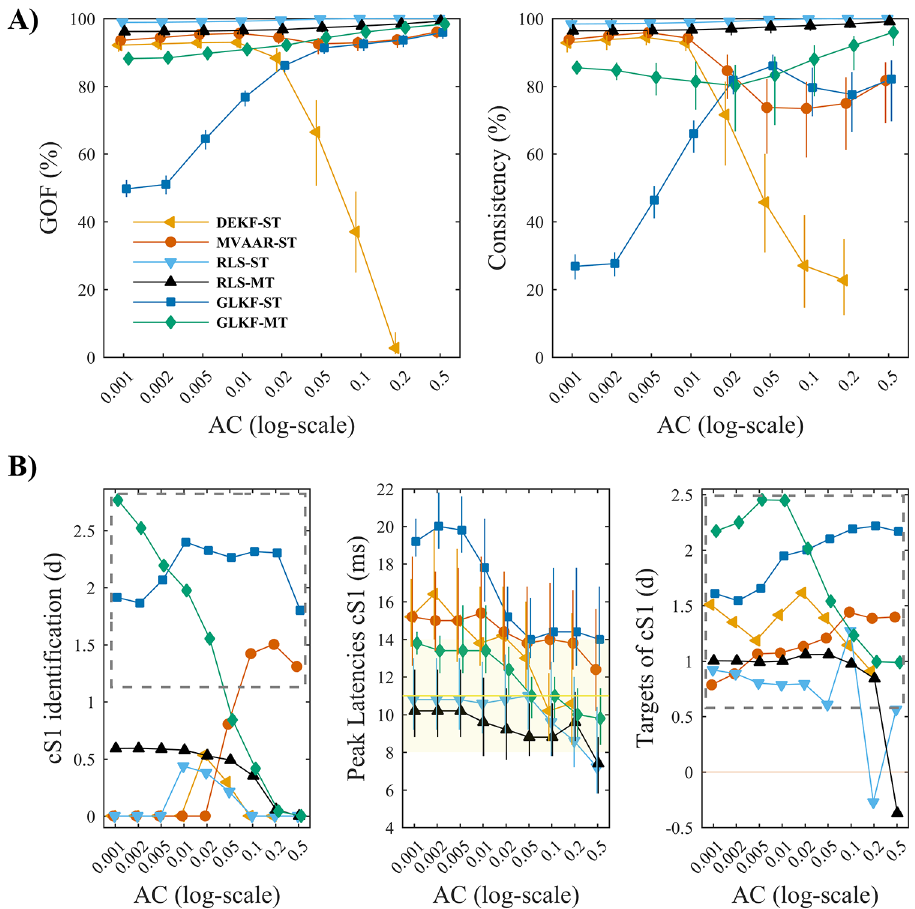
Fig 7. Effects of varying adaptation coefficients in benchmark EEG data. A) Shows the measures of model quality, goodness-of-fit (left) and percent consistency (right). Error bars denote bootstrapped 95% CI around the mean across animals. B) Shows the results of the performance assessment using the three performance criteria. Criterion I (left): gray dashed rectangle indicates conditions in which cS1 was significantly distinguished as main driver of the network. Criterion II (center): error bars denote bootstrapped 95% CI around mean peak latency across animals, while yellow band shows the range of physiologically plausible latencies after stimulus onset. Criterion III (right): gray dashed rectangle indicates conditions in which the driving from cS1 toward its two main targets was significantly larger than to medial electrodes equidistant from cS1. In each plot the results are shown as a function of the adaptation coefficients AC, using logarithmic scale for the x-axis, for the four recursive algorithms and the two ways of exploiting multiple trials: single-trial modeling and multi-trial modeling, available only for RLS and